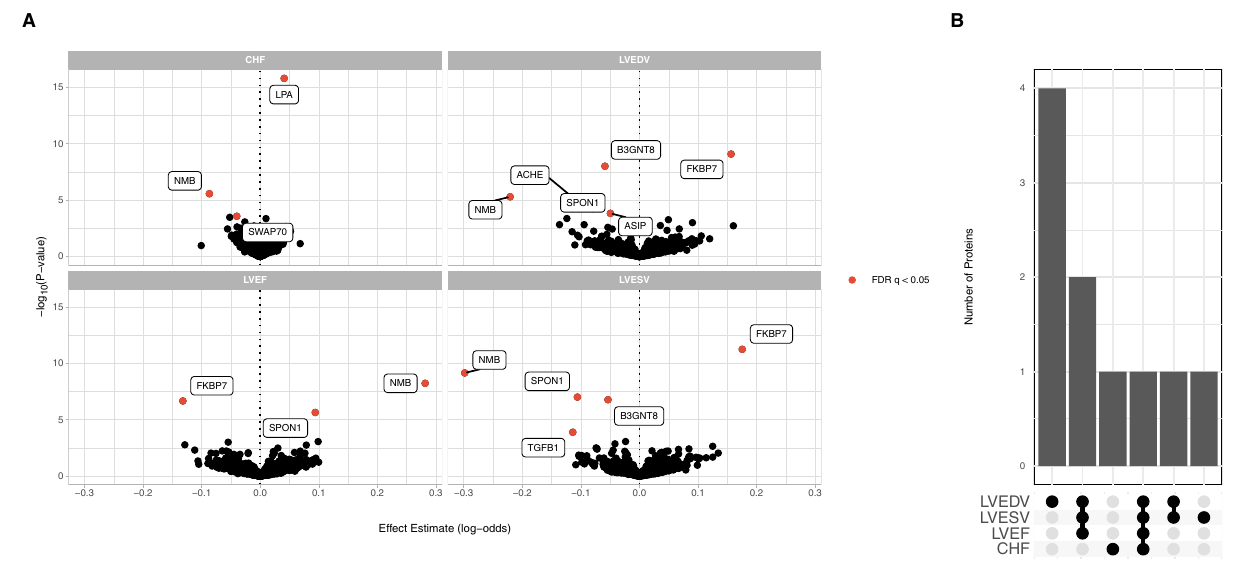
Fig. 7 | Proteome-wide Mendelian randomization. Proteome-wide MR was per- formed using high-con fi dence genetic instruments to detect associations between circulating proteins and cardiac endophenotypes. A Associations between